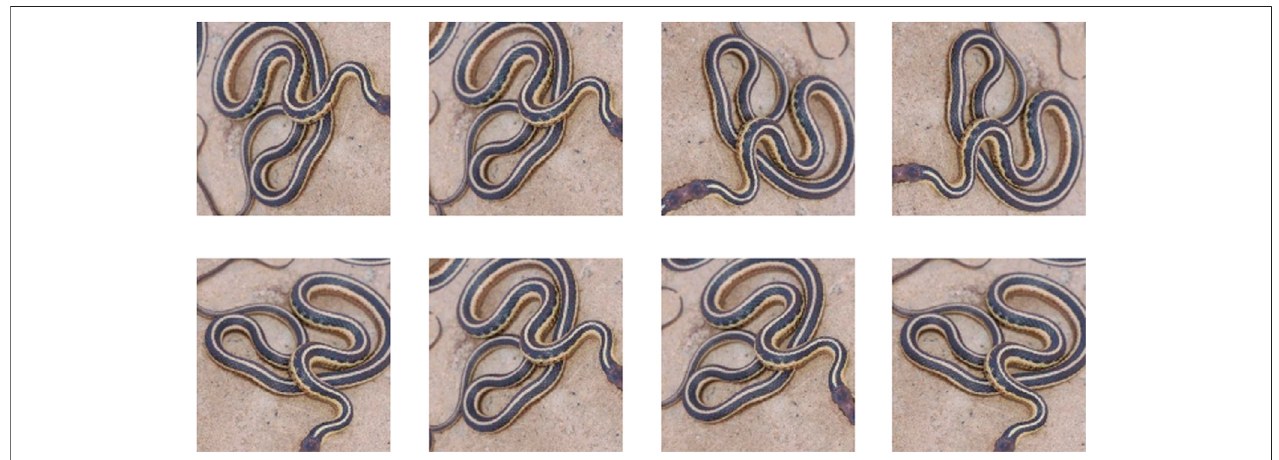
FIGURE 3 | Rotation augmentation of a sample